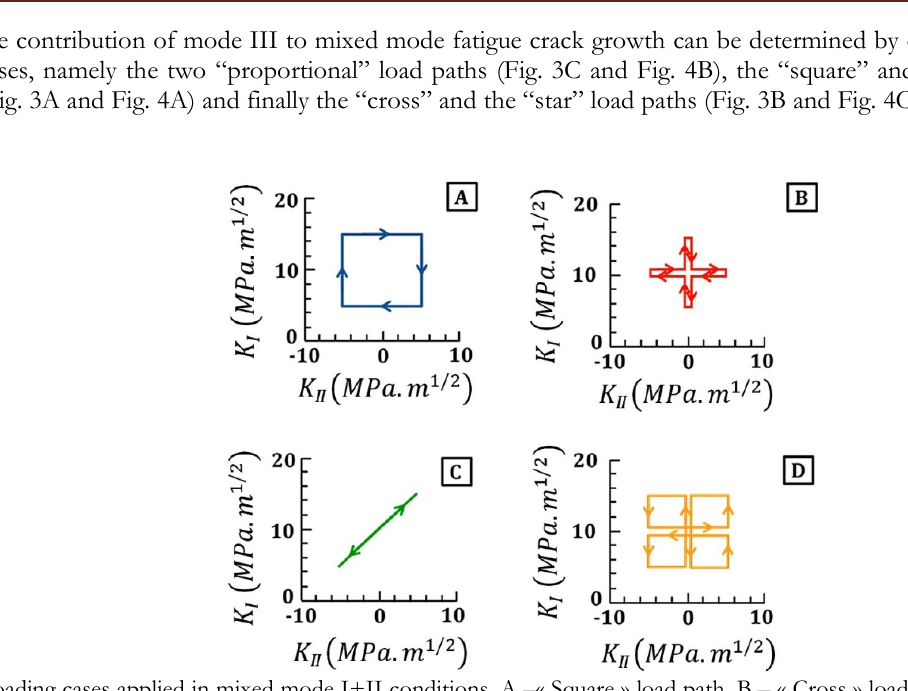
Figure 3: Loading cases applied in mixed mode I+II conditions. A –« Square » load path, B – « Cross » load path C – « Proportional » load path, D – « Windmill » load path.